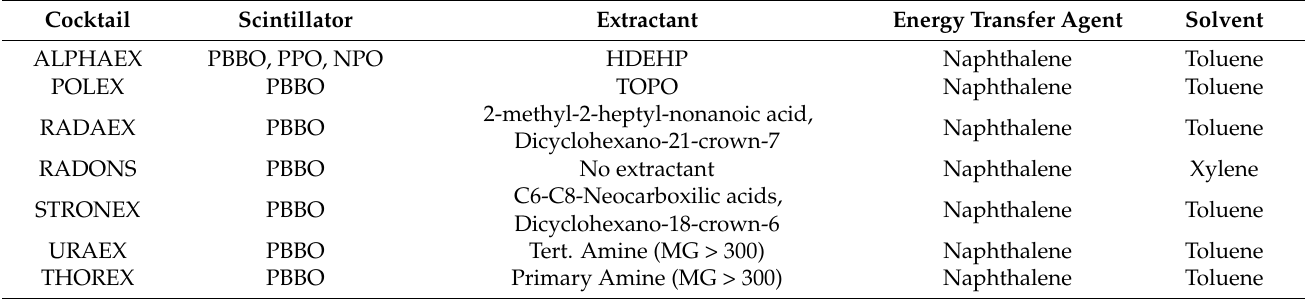
Table 2. Extractive cocktails for the PERALS methods (taken from [8]). PBBO: 2-(4 (cid:48) -biphenylyl)-6-phenylbenzoxazole, PPO: 2,5-diphenyloxazole, NPO: 2-(1-Naphthyl)-5-phenyloxazole, HDEHP: bis-(2-ethylhexyl)phosphoric acid, TOPO: Trioctylphosphine